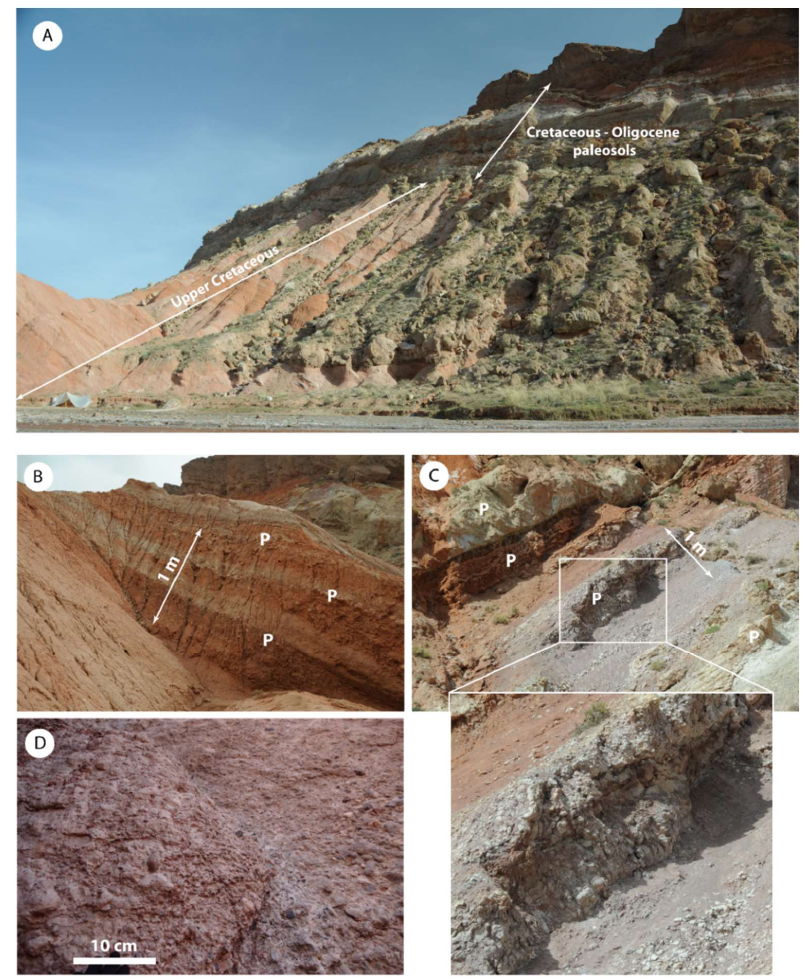
Figure 5. ( A ) General view of the Late Cretaceous to Paleogene series of the Yaha section. ( B ) Late Cretaceous calcareous paleosols. ( C ) Large scale view and details of the Late Cretaceous-Paleogene multilayered caliches. ( D ) Detailed view of a massive Late Cretaceous–Paleogene calcrete layer developed within a conglomerate.